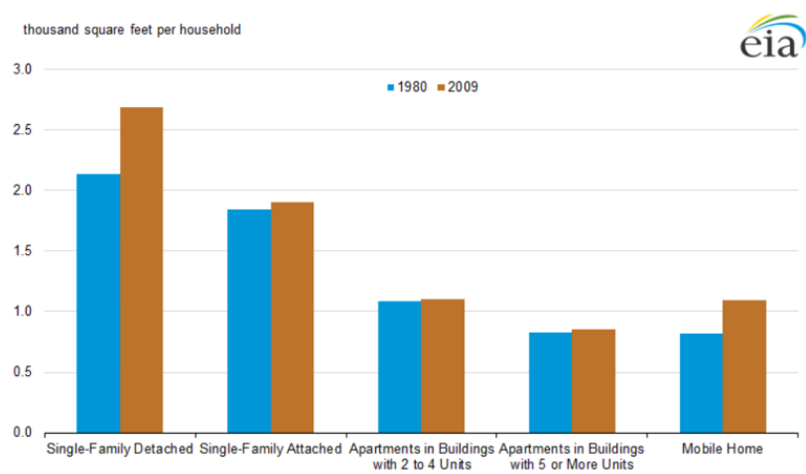
Figure 1. Size of residences by home type for 1980 and 2009 (ft 2 )